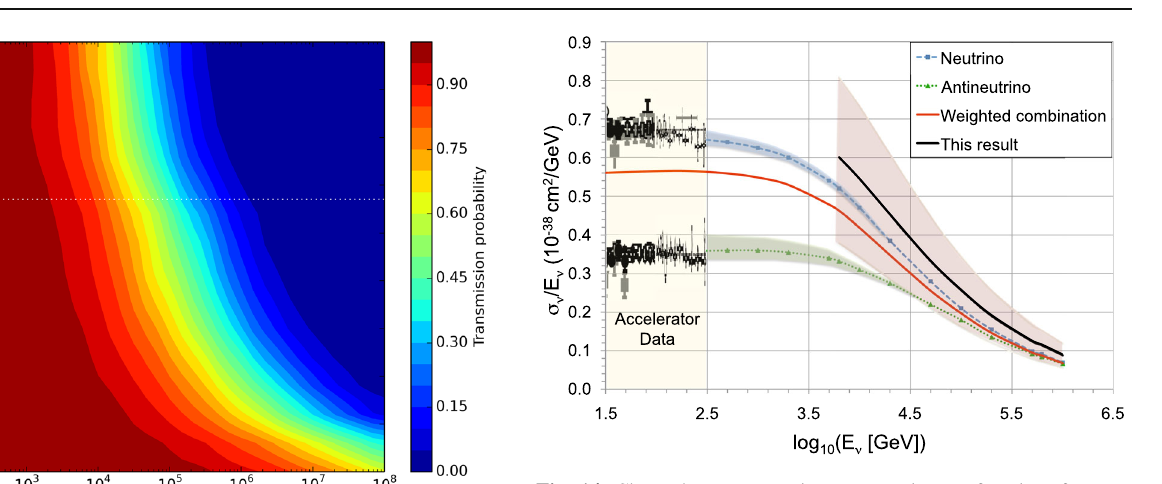
Fig. 14 Charged-currentneutrinocrosssectionasafunctionofenergy. Shown are results from previous accelerator measurements (yellow shaded area, from [41]), compared with the result from IceCube for the combined (ν + ν) + N charged-current cross section. The blue and greenlinesrepresenttheStandardModelexpectationfor ν and ν respec- tively. The dotted red line represents the flux-weighted average of the two cross sections, which is to be compared with the IceCube result, the black line. The light brown shaded area indicates the uncertainty on the IceCube measurement. Figure from